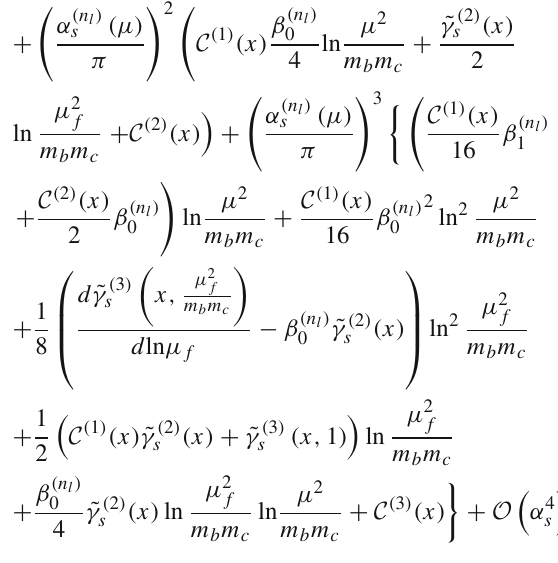
insertion of the scalar current. The thickest solid closed circle repre- sents the bottom quark loop, and the other solid closed circle represents (cid:21) the charm quark loop. The dotted closed circle represents the ghost ” implies the